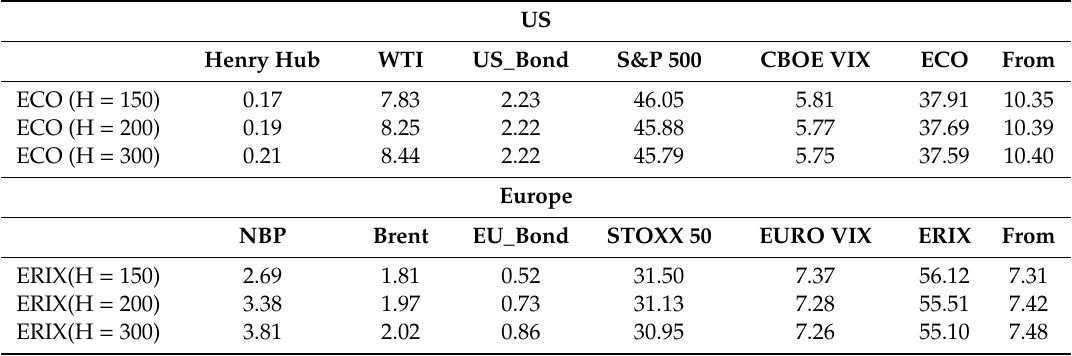
Table A2. Volatility spillover results under the di ff erent forecast